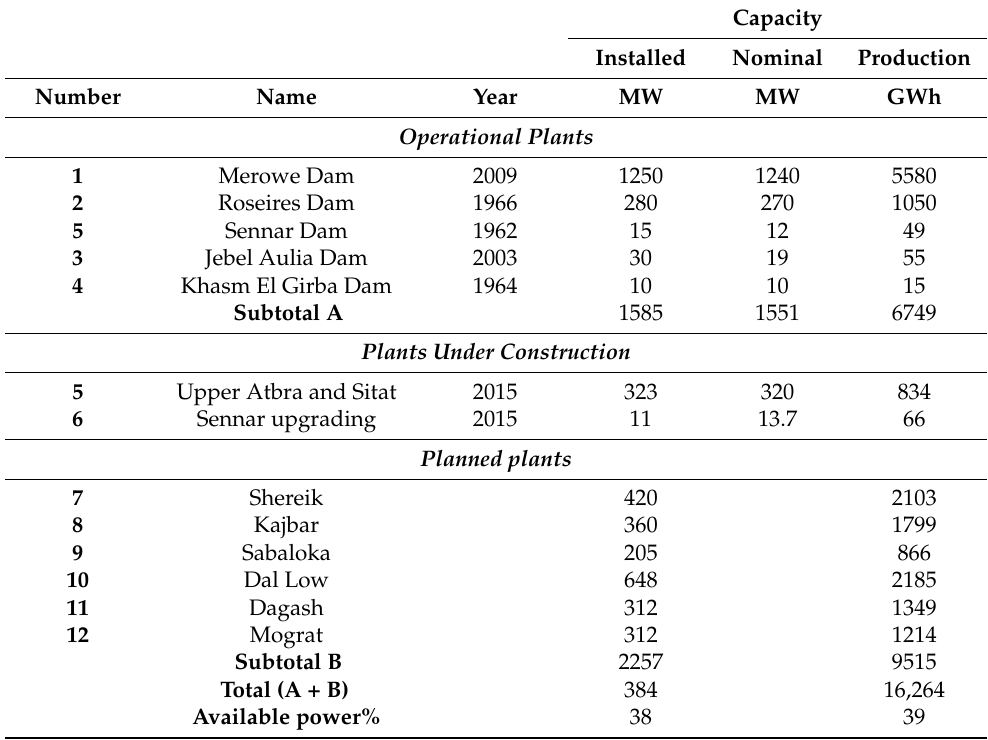
Table 7. Sudan hydroelectric power plant (operational, under construction, and planned)